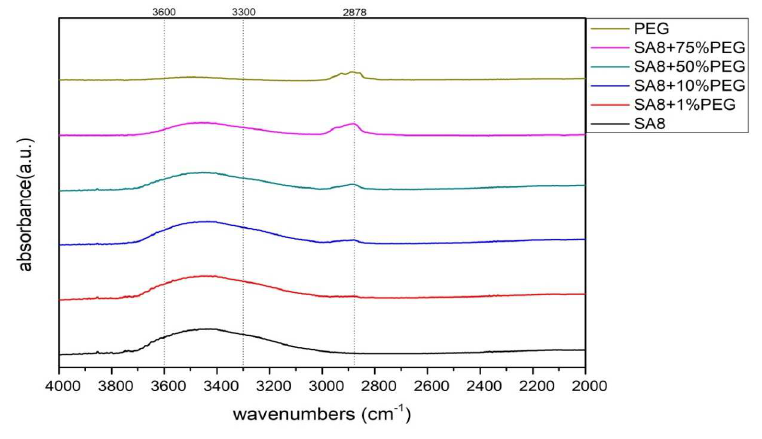
Figure 6. FT-IR spectra of SA8 blended with PEG series at 4000–2000 cm −1 .